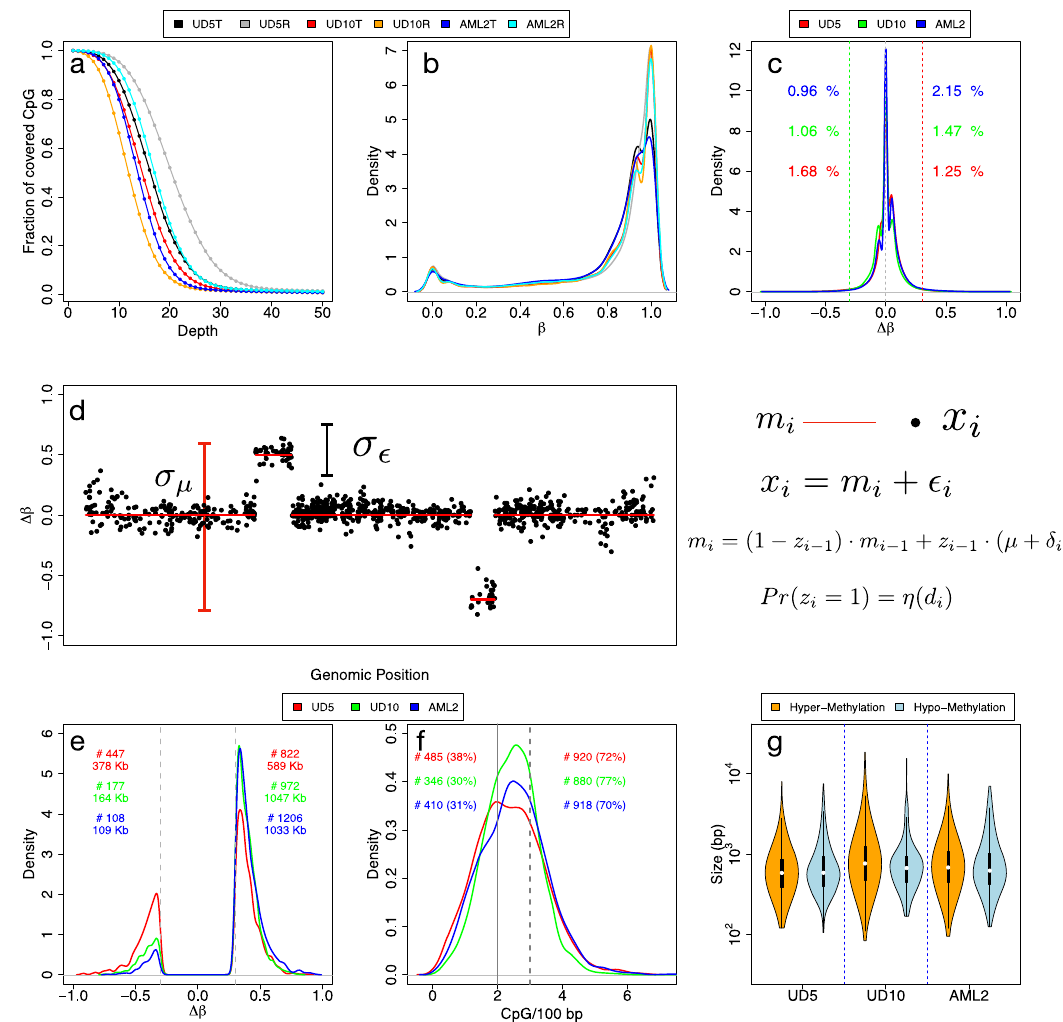
Fig. 1 Methylation frequency distribution and Poremeth. a Shows the fraction of covered CpG groups as a function of sequencing depth. b Reports the density distribution of β values, while c the density distribution of Δ β values. d Shows the SLM model. Δ β values are modeled as the sum of two independent stochastic processes m i and ϵ i , where m i is the unobserved mean level and ϵ i is normally distributed white noise ( ϵ i (cid:1) N ð 0 ; σ 2 ϵ Þ ). m i changes according to a geometric distribution (with parameter η ) incrementing its value by the normal random variable δ i ( δ i (cid:1) N ð 0 ; σ 2 μ Þ ) . To take into consideration the sparse nature of CpGs along the genome, the probability ( η ) to jump from two different state m i ( Pr ( z i ) = 1) depends the distance d i between consecutive CpGs. Distribution of the Δ β values of the DMRs detected by Poremeth on the three pairs of AML samples ( e , red for UD5, green for UD10 and blue for AML2). Text on left (right) side of the plot reports the total number (#) and total size (in kb) of hypomethylated (hypermethylated) DMRs. f Shows CpG density distribution of the DMRs detected by Poremeth on the three pairs of AML samples (red for UD5, green for UD10 and blue for AML2). Vertical continuous line indicates the resolution limit of WGBS ( ≤ 2 CpG/100 bp), while vertical dotted line indicates ERRBS resolution limit ( ≤ 3 CpG/100 bp). Text on left (right) side of the the plot reports the total number (#) and percentage (%) of DMRs detected by PoreMeth with CpG density ≤ 2 CpG/100 bp ( ≤ 3 CpG/100 bp). The violin plots in ( g ) show the size distribution of hyper-methylated (orange) and hypo-methylated (light-blue) DMRs detected by PoreMeth in the analysis of the three AML